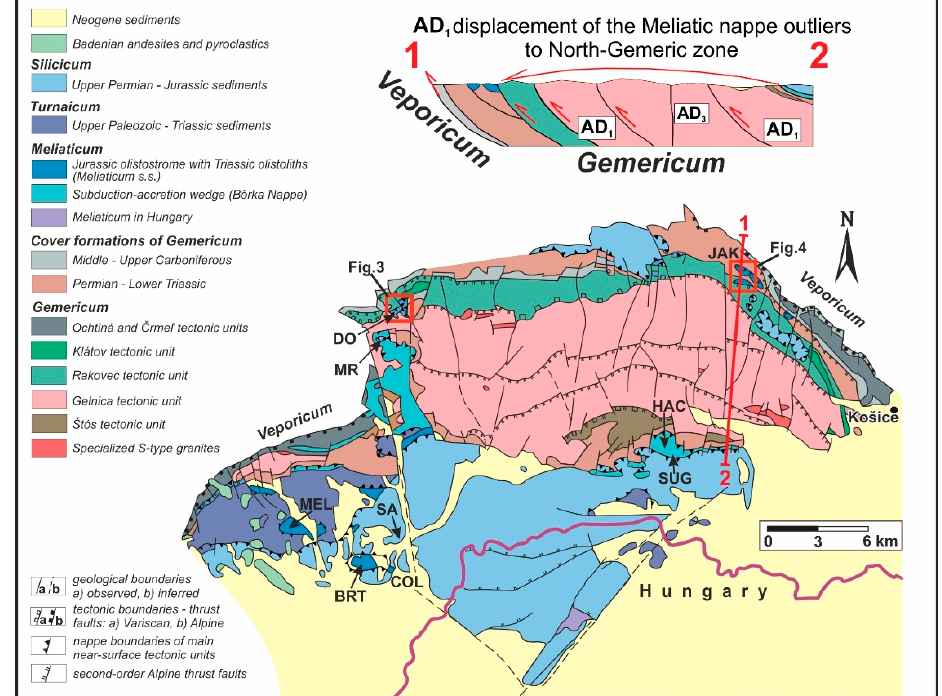
Figure 2. Tectonic map of the southeastern part of the IWC modified from [49,50] with originally defined two Meliatic units. Schematic cross-section documents general northward thrusting of the Meliaticum (and Silicicum) over the Gemericum. The investigated areas are marked by sample group abbreviations for the Dobšiná (DO), Jaklovce (JAK), Malý Radzim Hill near Brdárka (MR), Meliata (MEL), Bretka (BRT), Č oltovo (COL), Ha č ava (HAC), Šugov Valley (SUG) and Gemerská Hôrka (SA-6) localities. For the displacement of the Meliatic nappe outliers and their meso- and microstructures, see Supplementary Figures S1–S8.